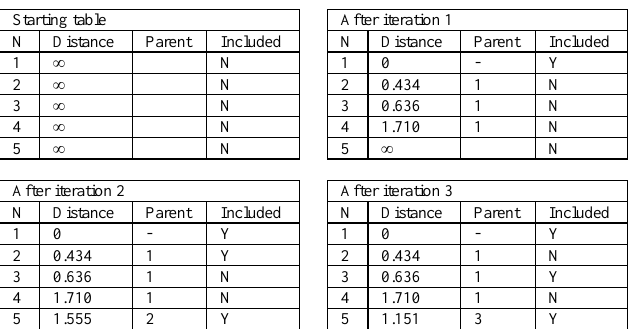
Table 1: Starting table and tables after each iteration of Dijkstra's